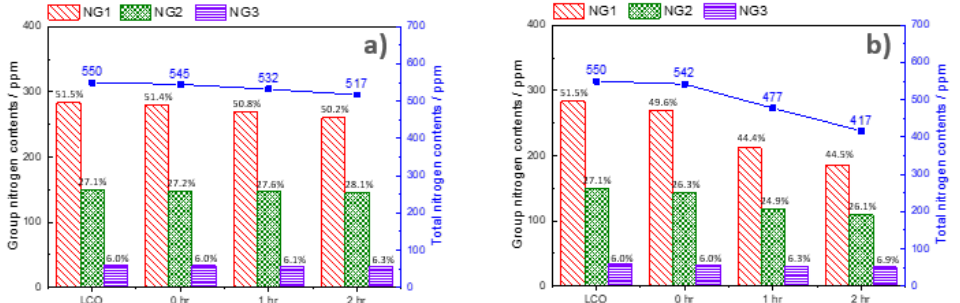
Figure 6. The fraction of the N compounds of NG1, 2, and 3 in the LCO and the products after the HDN over ( a ) CoMoS and ( b ) NiMoS .